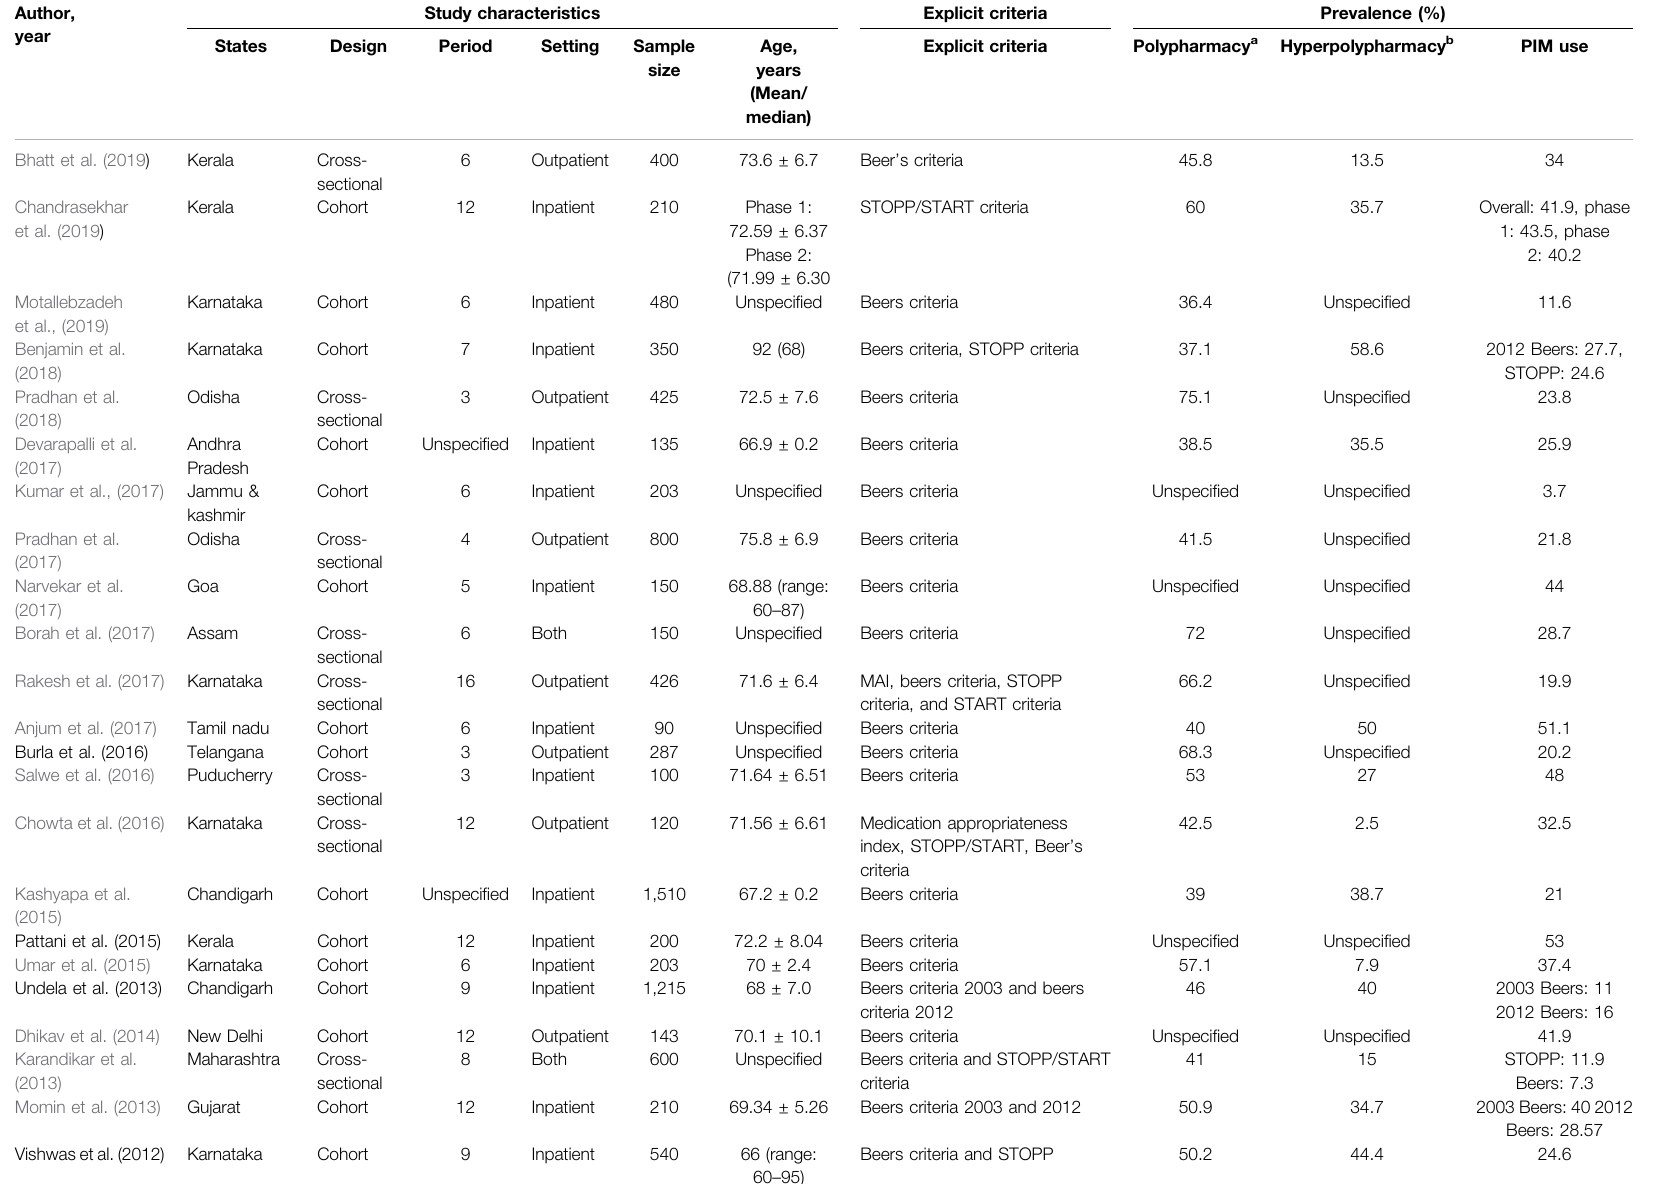
TABLE 1 | Characteristics of included